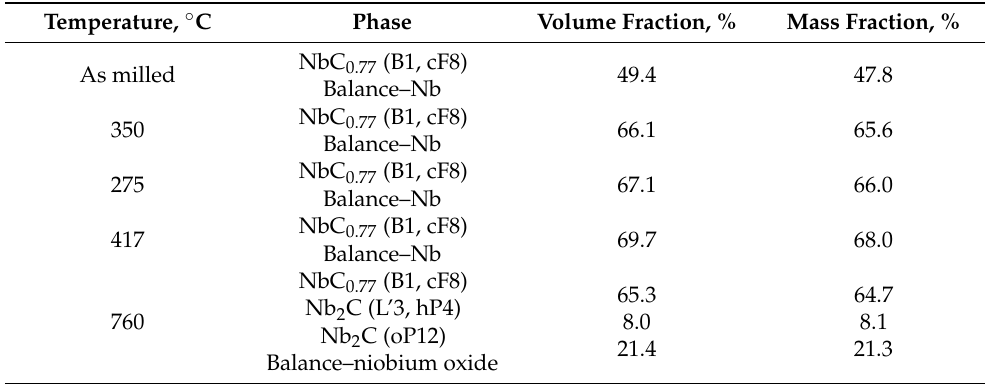
Table 4. Content of phases in the sample processed in the planetary mill for 6 h after various thermal processing. Temperature, ◦ C Phase